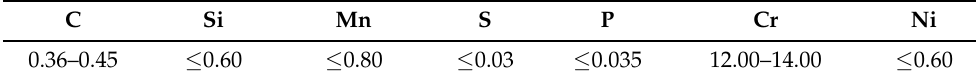
Table 1. Main components of 40Cr13 stainless steel (wt%).